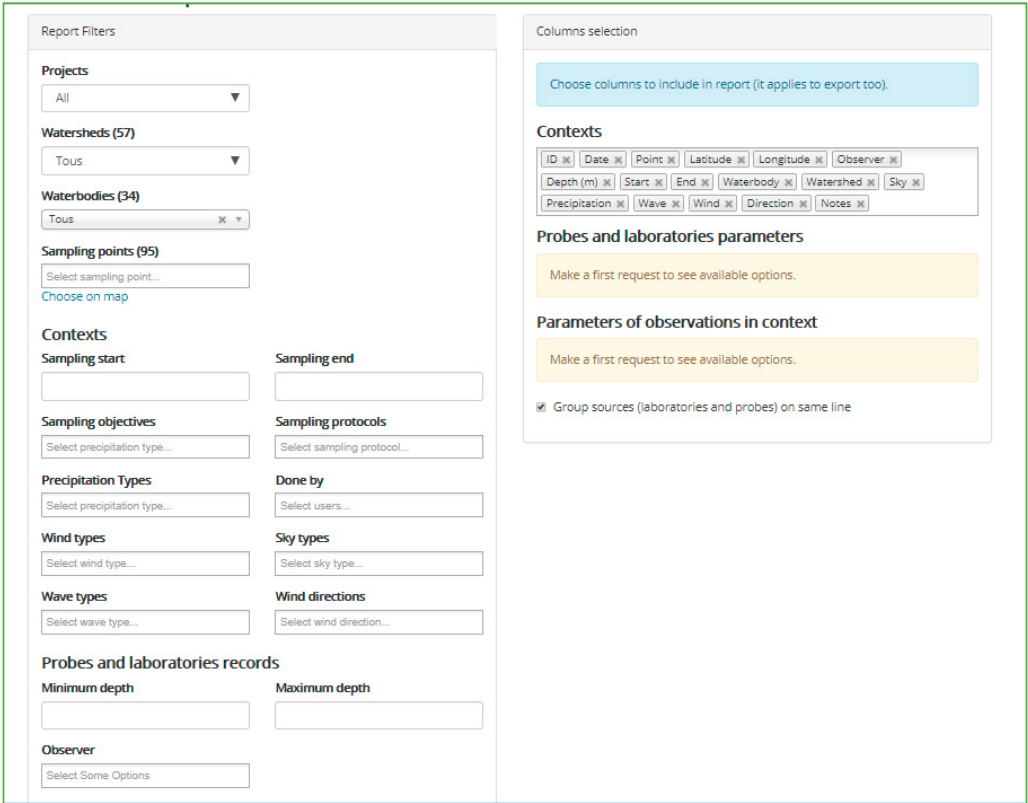
Figure 7. Illustration of the available filters for data extraction. It is possible to make 1 or n selections to visualize data series or to export selection to EXCEL or CSV